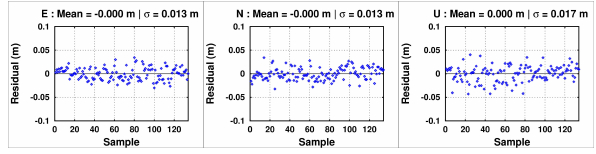
Figure 11: Residuals of 3d similarity and delay estimation Precision on residuals after estimation of 3d similarity and elec- tronical delay is belox 2 cm for all axial components. The value estimated for electornic delay is 93 ms . Residuals on check points are computed to evaluate the absolute accuracy of our pro- totype using pseudo-materialization method for lever-arm cali-